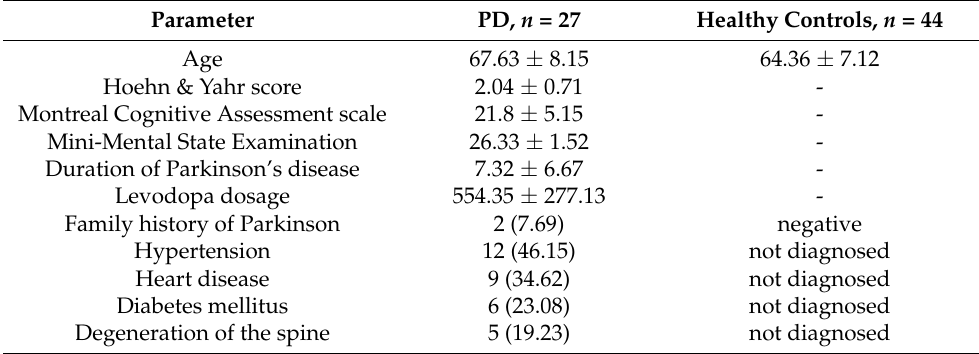
Table 1. Baseline characteristics of the study groups, PD and healthy controls. Mean ± SD or n (%).